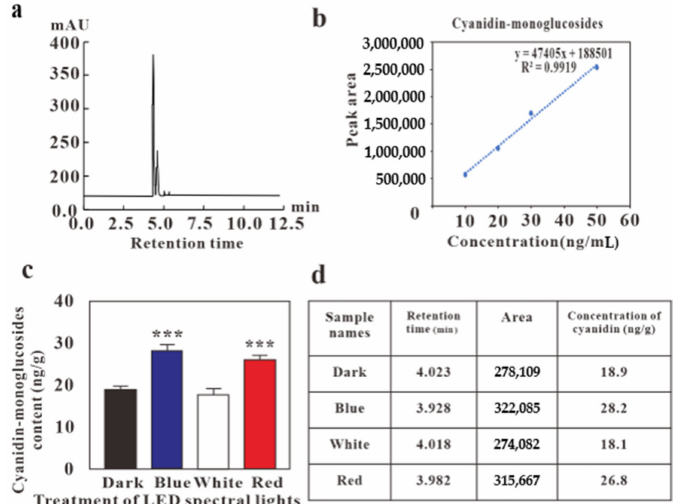
Figure 3. HPLC profile for the e ff ect of LED lights for cyanidin-monoglucoside content in G. procumbens callus ( a ) peak of cyanidin-monoglucosides ( b ) standard curve ( c ) HPLC results ( d ) retention time and area of cyanidin-monoglucosides. Values are means ± standard deviation (SD) from three replicates ( n = 3). Ordinary one-way ANOVA followed by Dunnett’s multiple comparisons test were performed, where p < 0.001 are represented as